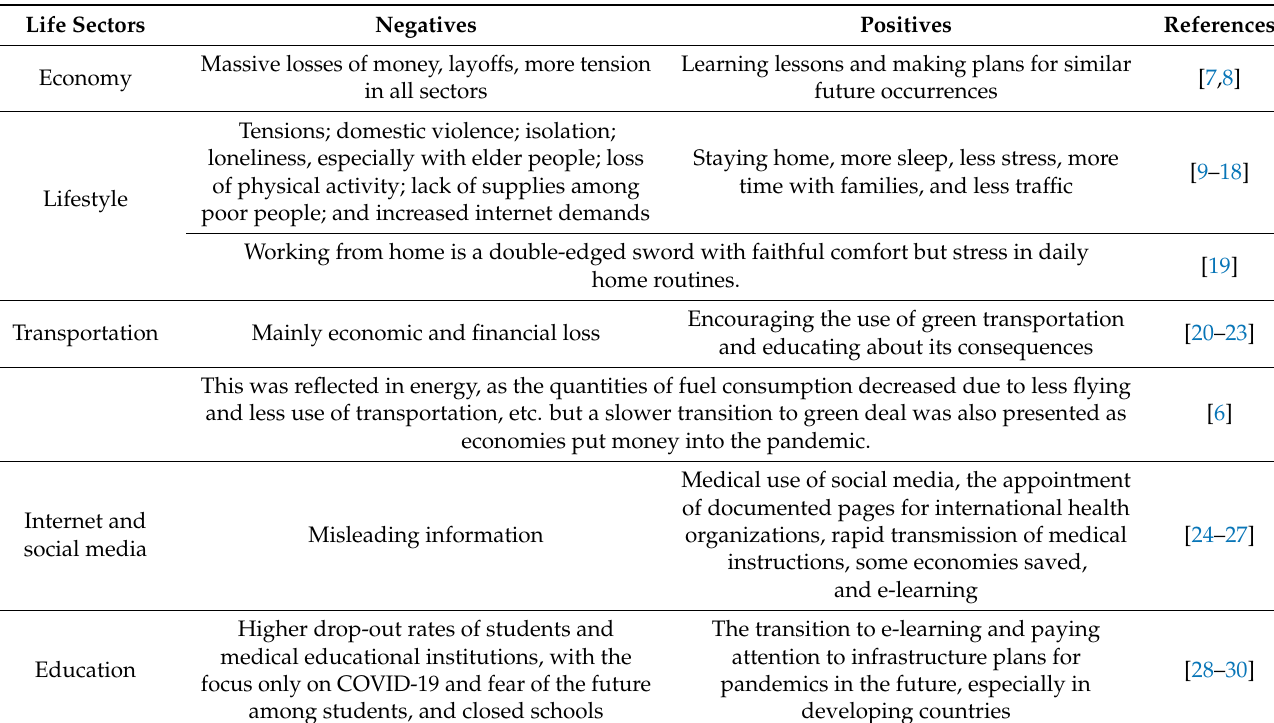
Table 1. Some negative and positive consequences of the COVID-19